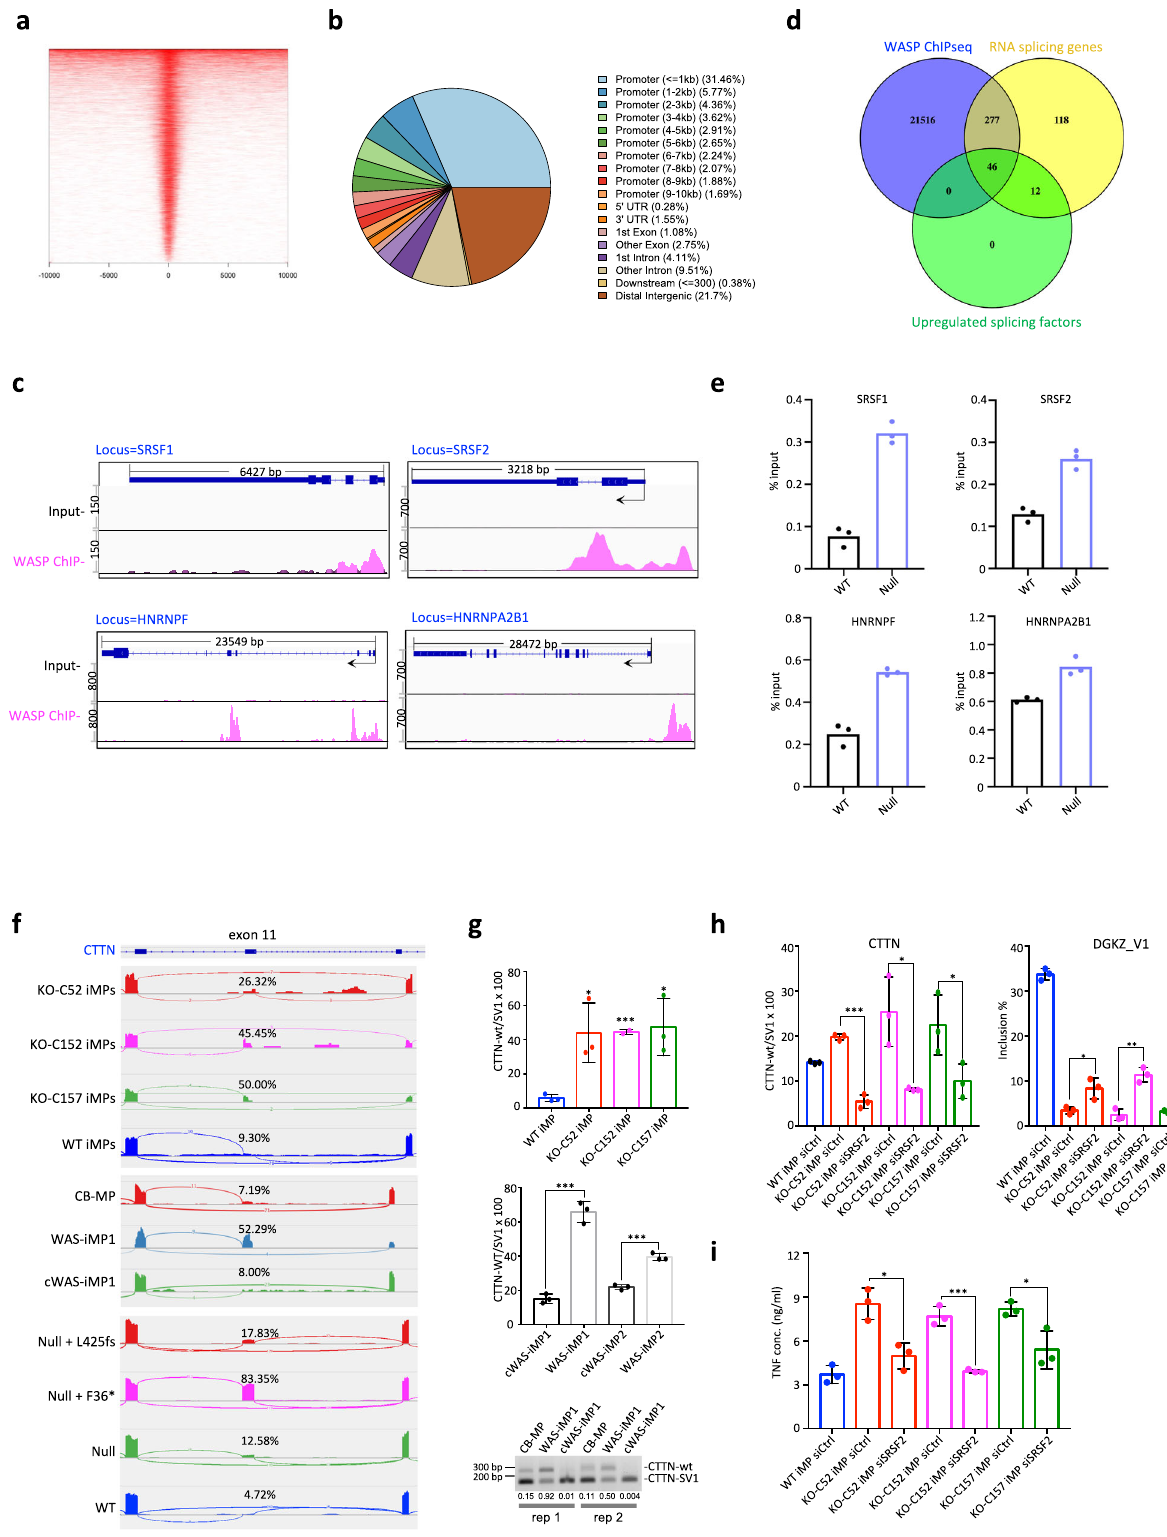
nuclear bodies with phase-separated, liquid-like properties that allow their constituents to shuttle between the nuclear body and nucleoplasm dynamically and transiently interact with nucleo- plasmic factors 46,47,67 . These phase-separated condensates are driven by intrinsically disordered proteins (IDPs) that contain intrinsically disordered regions (IDRs) 12 . Intriguingly, WASP